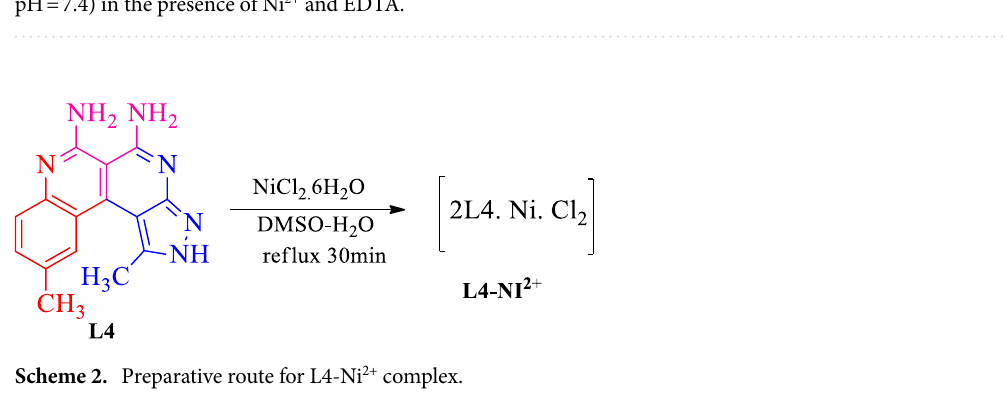
Figure 7. Changes in absorbance spectra of L4 (20 µM) in DMSO – H 2 O solution (1:2 v/v, HEPES buffer, pH = 7.4) in the presence of Ni 2+ and EDTA.